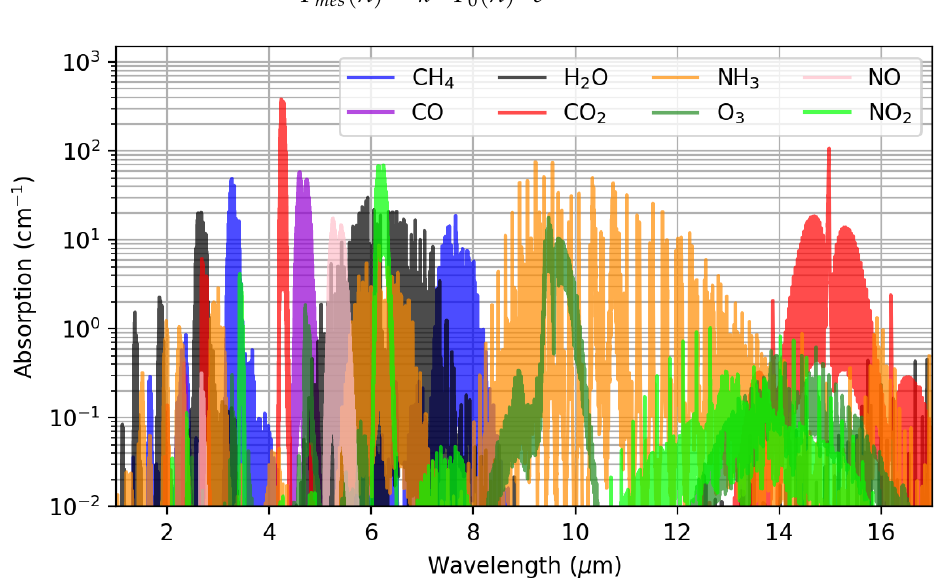
Figure 1. Mid infra-red absorption spectra of various gases, only CO 2 absorbs at 4.26 µm. Data source: HITRAN database [28]. A Lorentzian broadening profile was considered for a dilution in air at 1 atm and 296